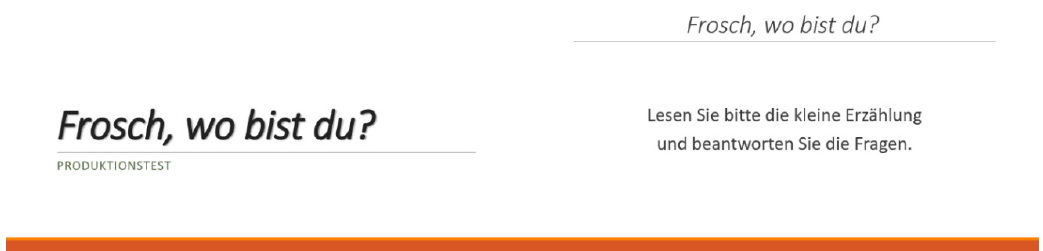
Figure A2. Pretest: Production task.